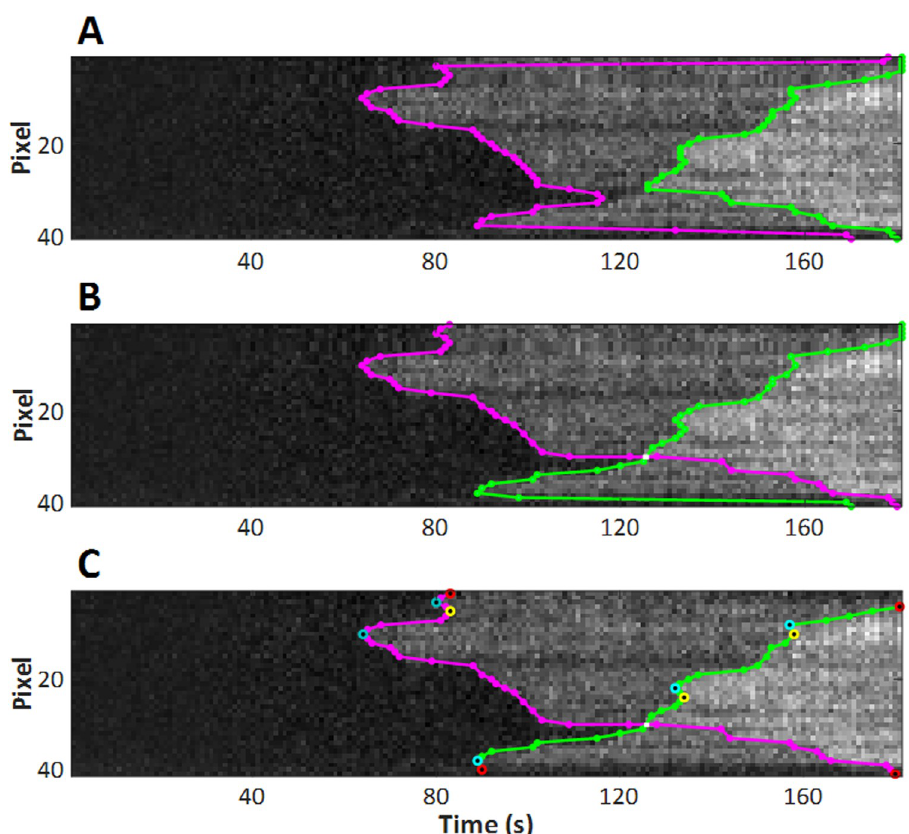
Fig 5. Crossing boundaries editing. (A) Boundaries as determined by intensity thresholding. The outer boundary occurs at the earlier time and lower intensity threshold (magenta) and the inner boundary is the later time, higher intensity threshold (green). (B) Boundaries after user editing. The boundaries have been cut and joined to show the likely cross-over–each boundary then indicating binding on different sides of the actin filament. (C) Nucleation points (light blue circles) and meeting points on the same groove (yellow circles) can be automatically detected at the extrema in each time-pixel boundary. Other points of interest can also be marked by the user to allow for other analyses.